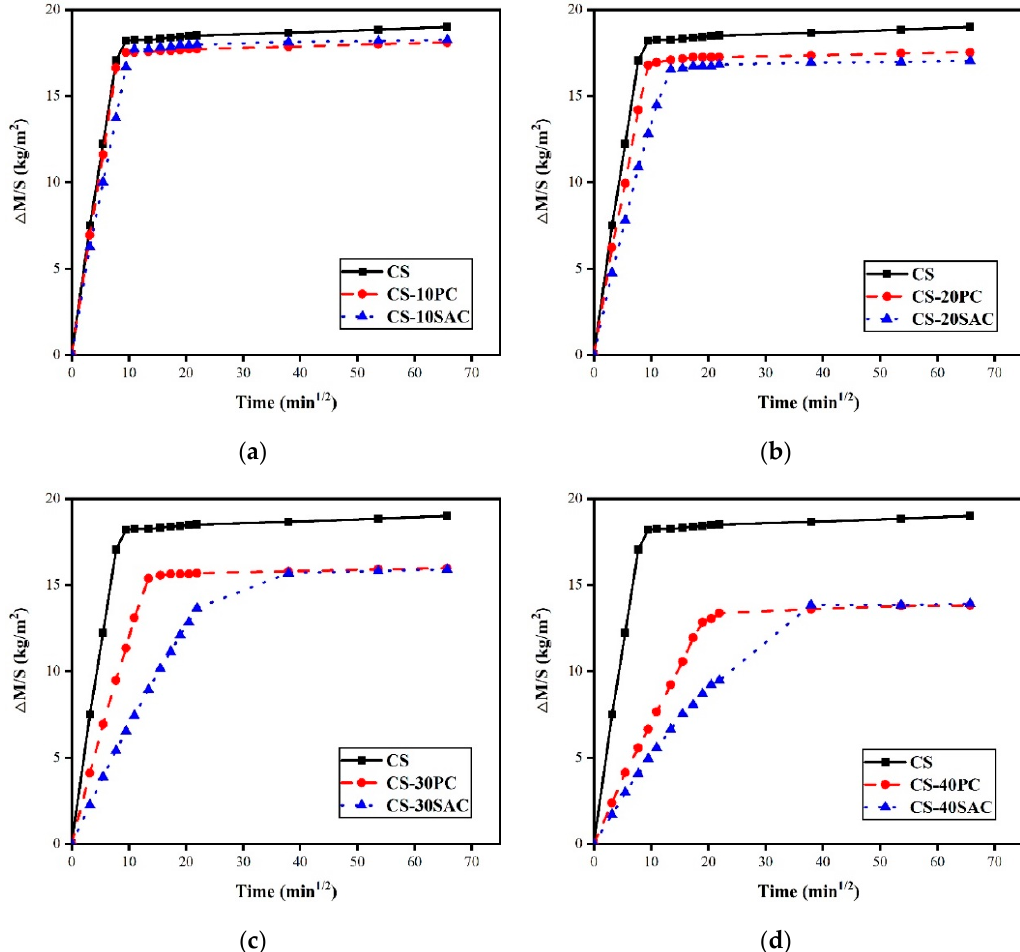
Figure 5. Curves of water absorption by capillarity of blended mortars at 28 days: ( a ) Blended mortars containing 10% cement; ( b ) blended mortars containing 20% cement; ( c ) blended mortars containing 30% cement; ( d ) blended mortars containing 40% cement.